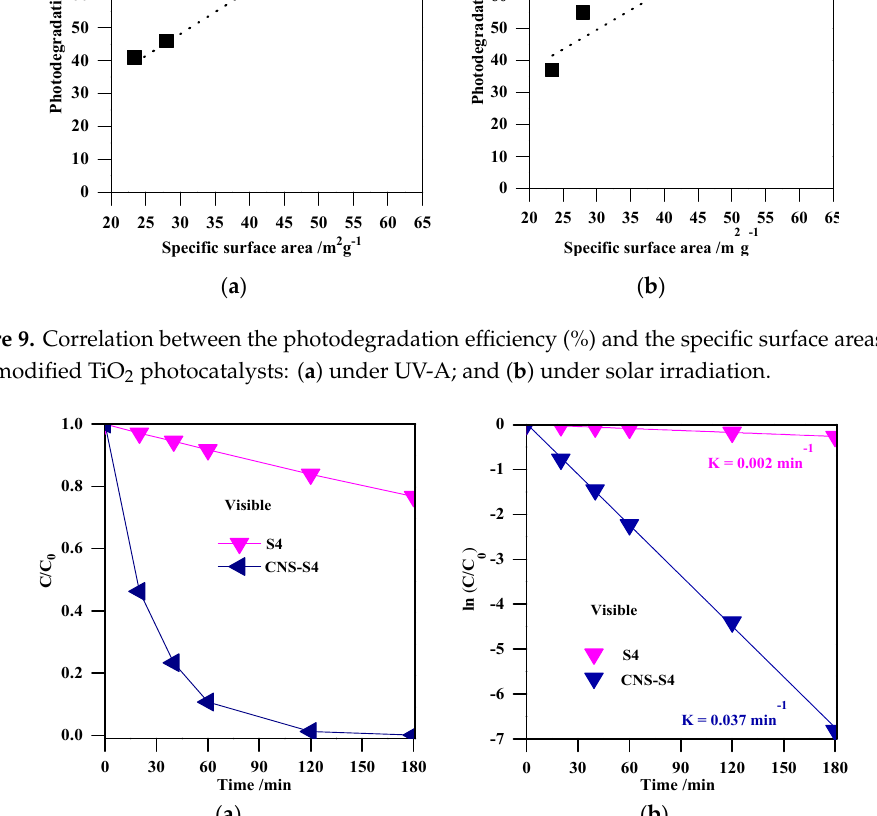
Figure 10. ( a ) change of the MC-LR concentration during visible light irradiation; ( b ) plot of ln (C/C 0 ) versus irradiation time. Photocatalyst loading (S4, CNS-S4), 0.4 g L − 1 ; MC-LR dose, 10 mg L − 1 ; pH, 4; T, 25 °C; reaction volume 40 mL.